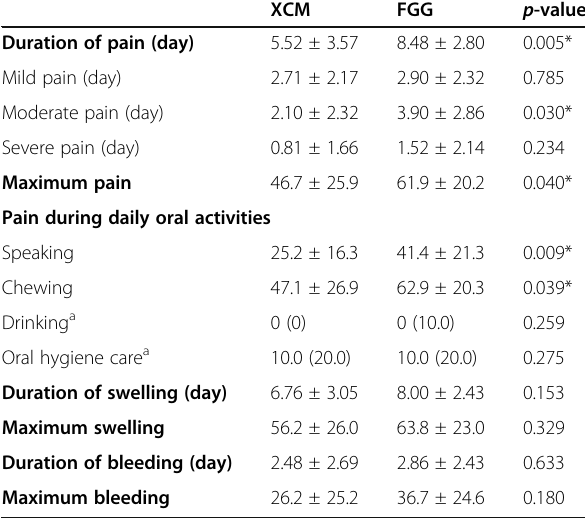
Table 1 Baseline demographic data